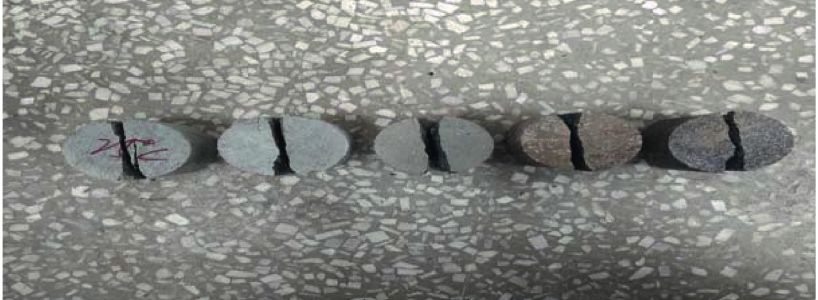
Figure 13: Failure mode of Brazilian disc splitting test for